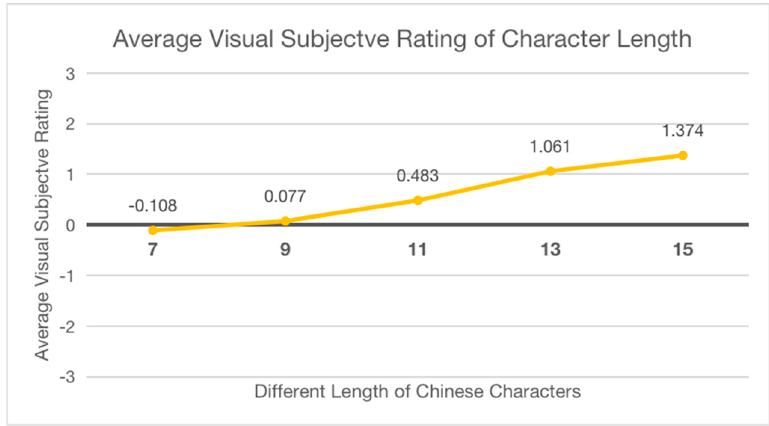
Figure 6. Average visual subjective rating of Chinese characters’ length.